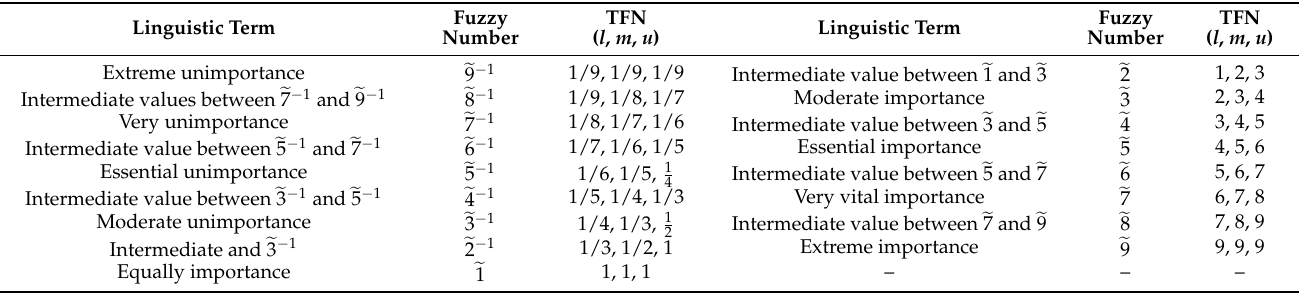
Figure A1. The α -cut of a triangular fuzzy number T ̃ Source: [26]. Table A1. Fuzzy scales and triangular fuzzy numbers (TFN) used for linguistic